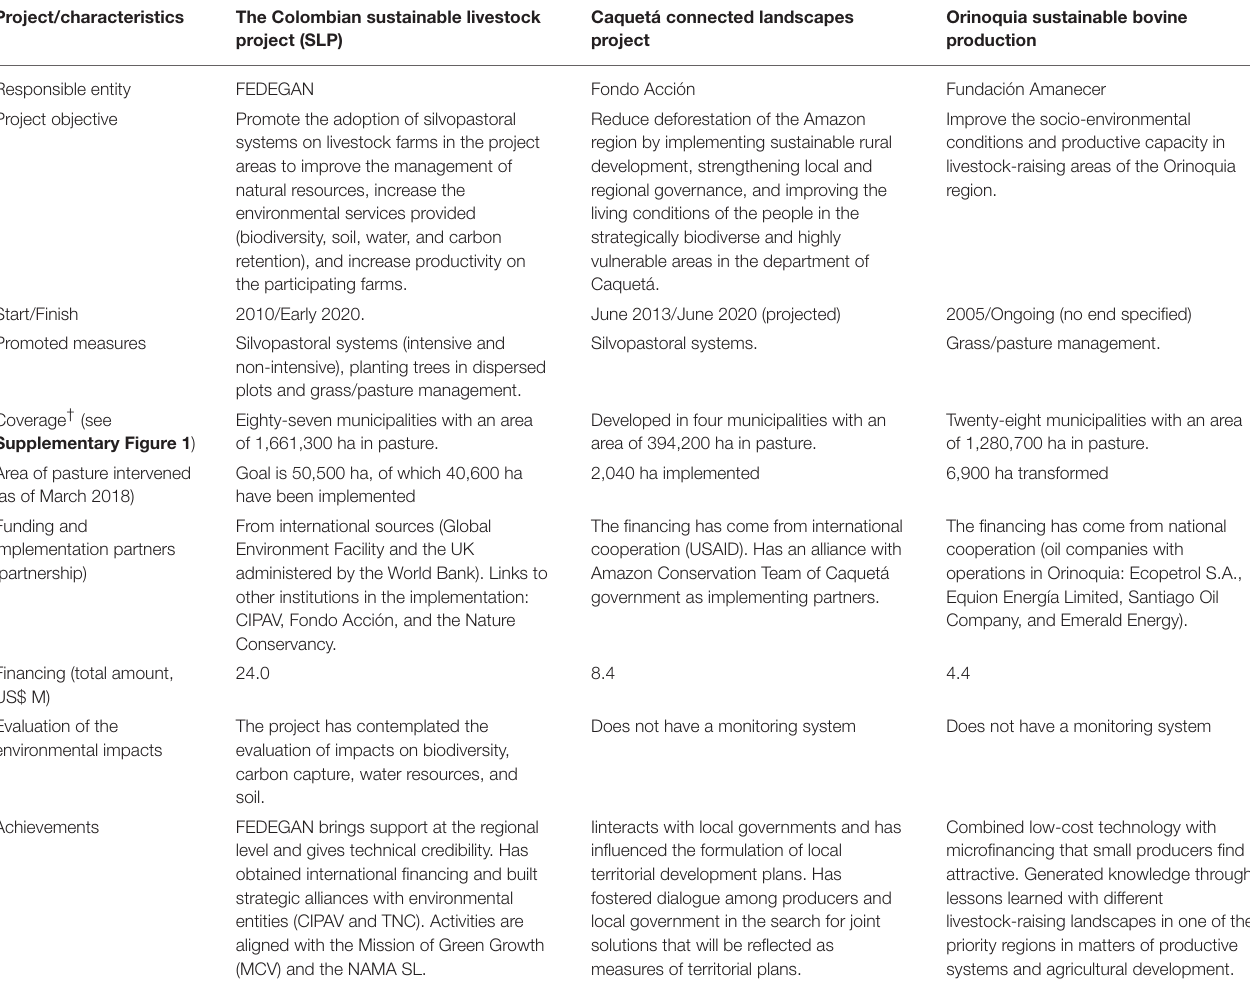
TABLE 2 | General description of the three projects